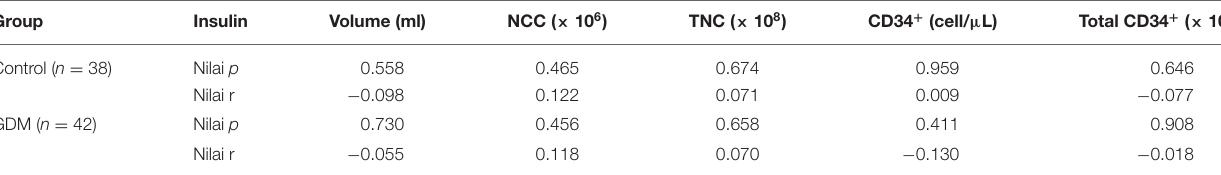
TABLE 4 | A correlation between UCB parameters and insulin level in GDM and control groups. Group Insulin Volume (ml) NCC ( × 10 6